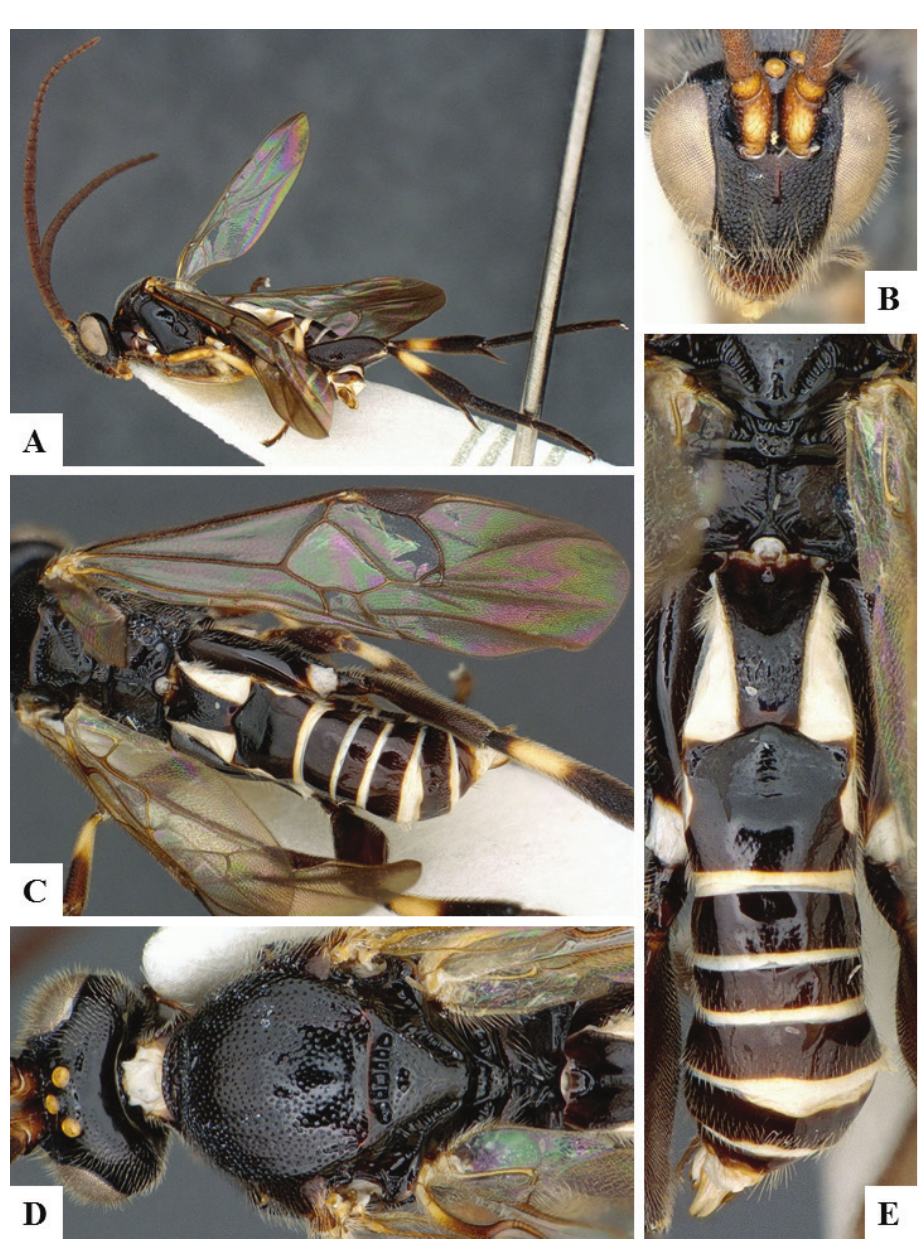
Figure 5. Agupta jeanphilippei male paratype CNC497191. A Habitus B Head frontal C Fore wing D Head and mesosoma, dorsal E Propodeum and metasoma, dorsal. A. danyi , which has a lighter color (yellow-orange or yellow-white) of mesosoma and first two pairs of